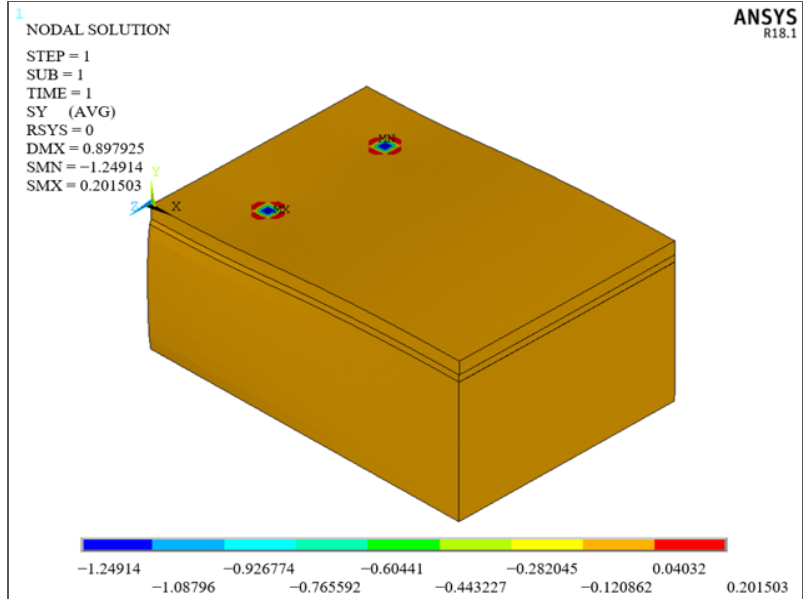
Figure 4. The minimum and maximum stresses in the Y direction (ANSYS R18.1). In Figure 5, the minimum and maximum stresses in the X direction are presented. The minimum and maximum stresses were calculated to be − 1.864 MPa and 1.488 MPa, respectively.